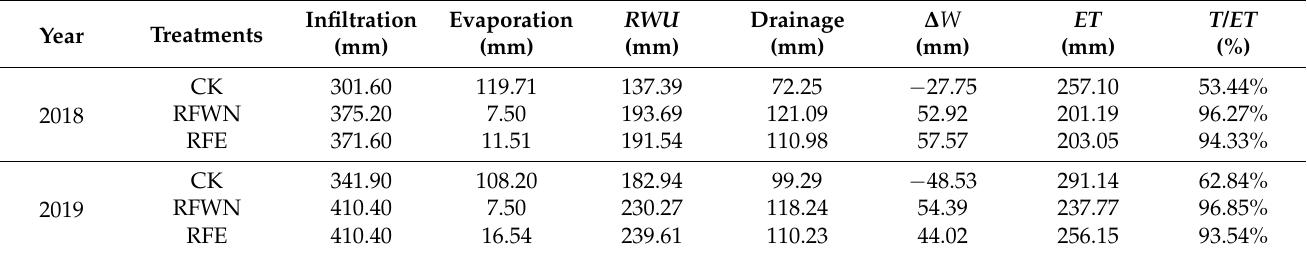
Table 4. Estimated water balance with HYDRUS-2D under different treatments for growth